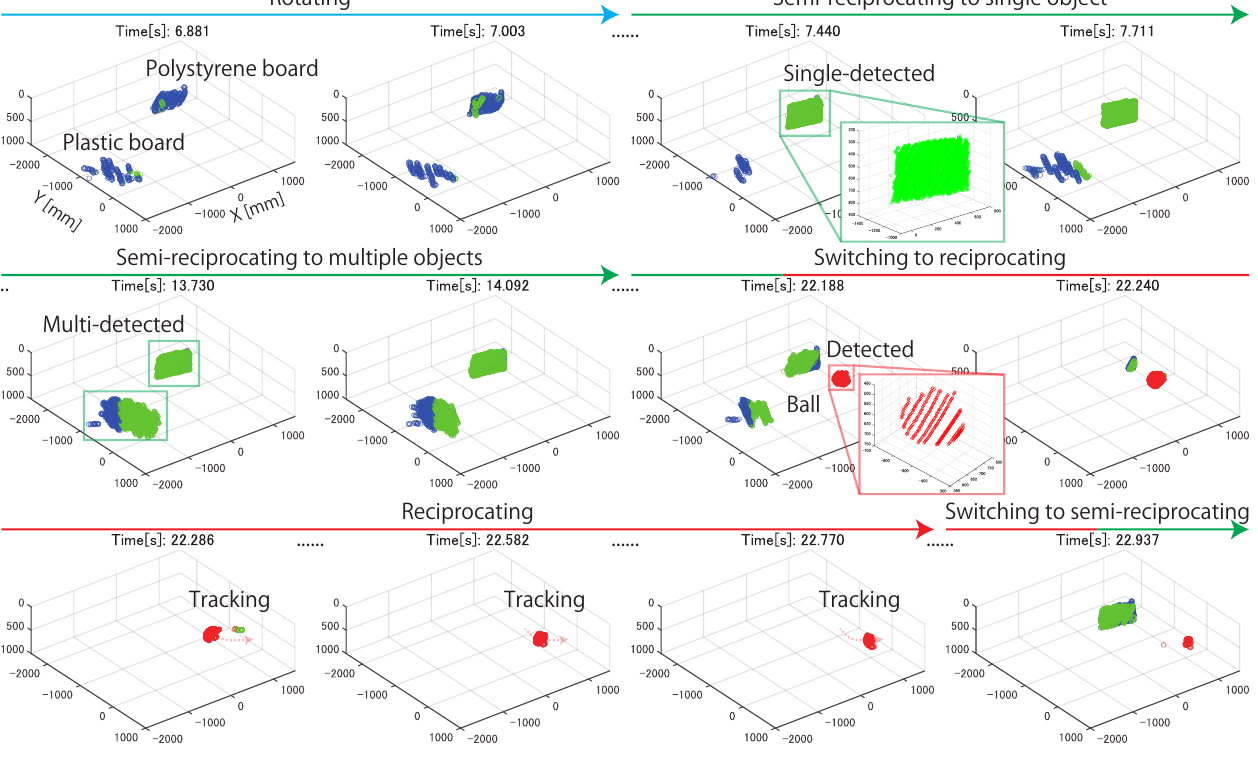
Figure 14. Time transition of 3D sensing results from AdjustSense. Blue, green, and red dots indicate measured 3D points whose distances from high-speed omnidirectional camera were more than D 1 , less than D 1 , and less than D 2 ,